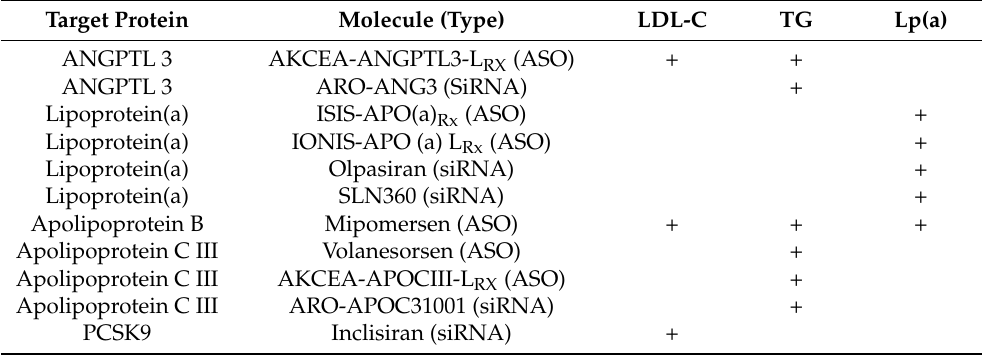
Table 2. The main effects of the overviewed molecules and their targets on LDL, TG, and Lp(a). Target